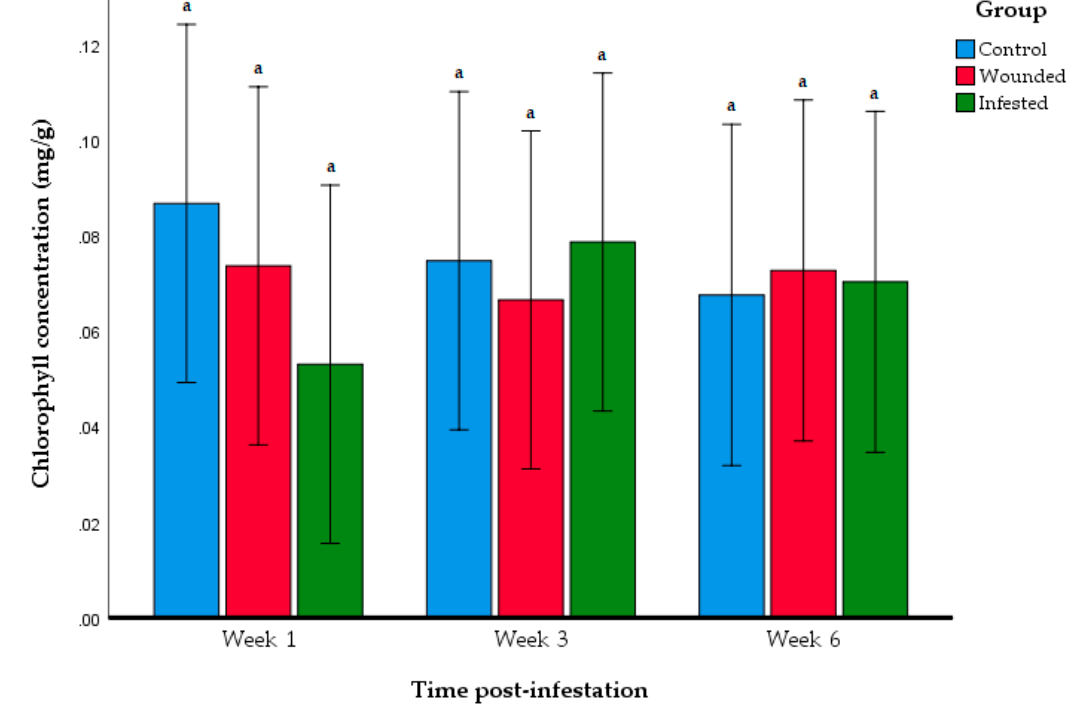
Figure 6. Total chlorophyll content of E. guineensis in each group at different periods after infestation. Data shown as mean + S.D. Different letters indicate significant differences among the control, wounded, and infested group based on ANOVA following the Tukey multiple comparison test ( p > 0.05).